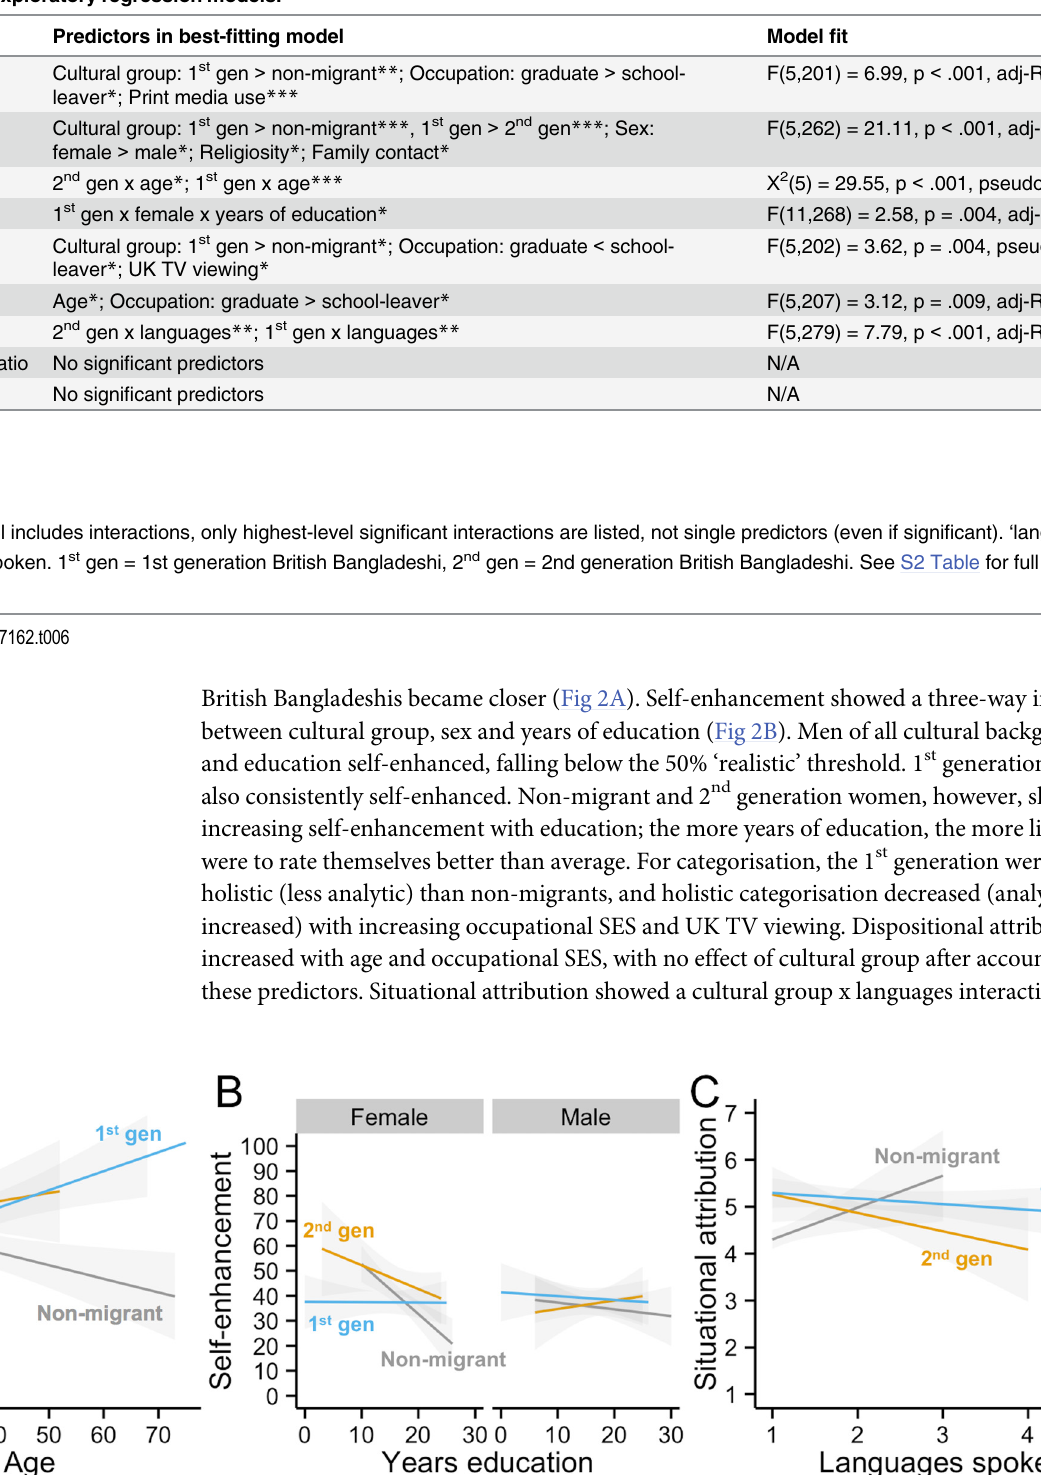
Table 6. Summary of exploratory regression models.